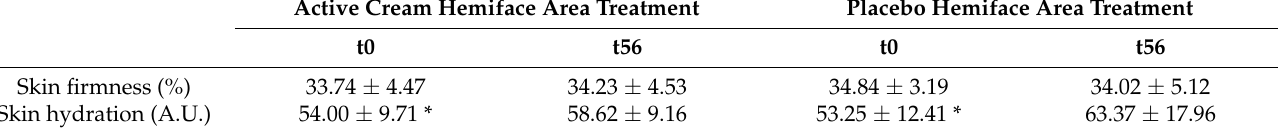
Table 3. Mean values of face skin firmness obtained through the Cutometer ® SEM 575 analysis and mean values of face skin hydration obtained through the Corneometer ® CM825 analysis. The measurements performed before (t0) and after 56 (t56) consecutive days of application, twice daily, of the active cream and the placebo. The results are expressed as mean ± SD ( n = 22). * in the same row indicates significant differences between timepoints ( p <